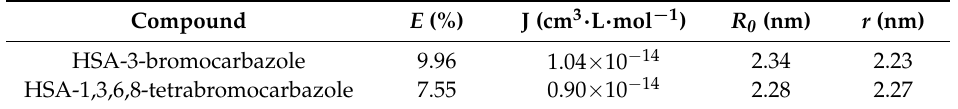
Table 6. Parametersof E , J , R 0 and r ofHSA-3-bromocarbazoleandHSA-1,3,6,8-tetrabromocarbazolesystems.